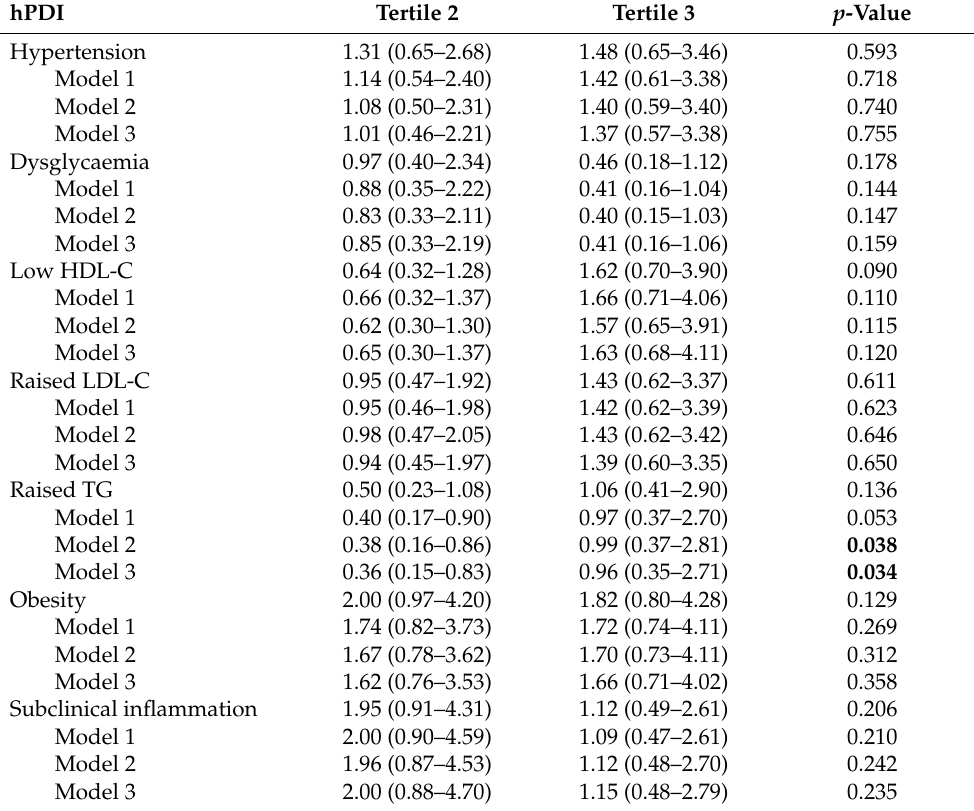
Table 5. Associations between hPDI and cardiometabolic risk profiles.